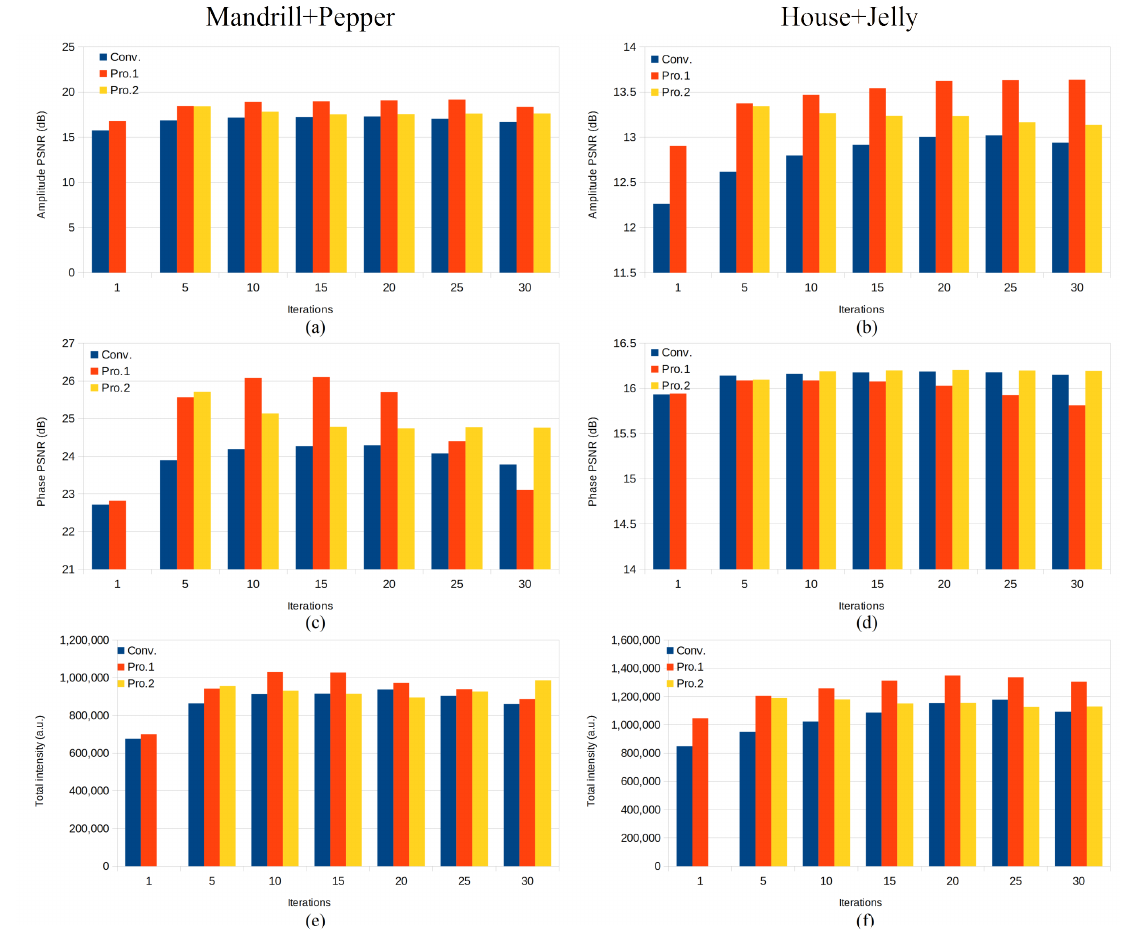
Figure 8. Reconstructed amplitude images, phase images, and total intensity as a function of the iterations. The resolution of the hologram is 2048 × 2048 pixels. ( a , b ) are the amplitude PSNRs for “Mandrill+Pepper” and “House+Jelly”, ( c , d ) the phase PSNRs for “Mandrill+Pepper” and “House+Jelly”, and ( e , f ) are the total intensities for “Mandrill+Pepper” and